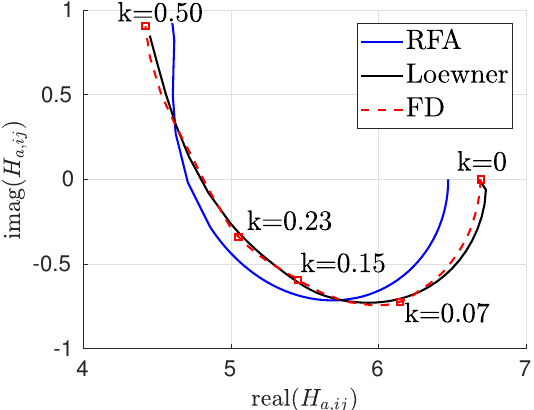
Figure 11. Element of the transfer function matrix from the pitch input to the lift coefficient for the strip at the wing station y = 13.48